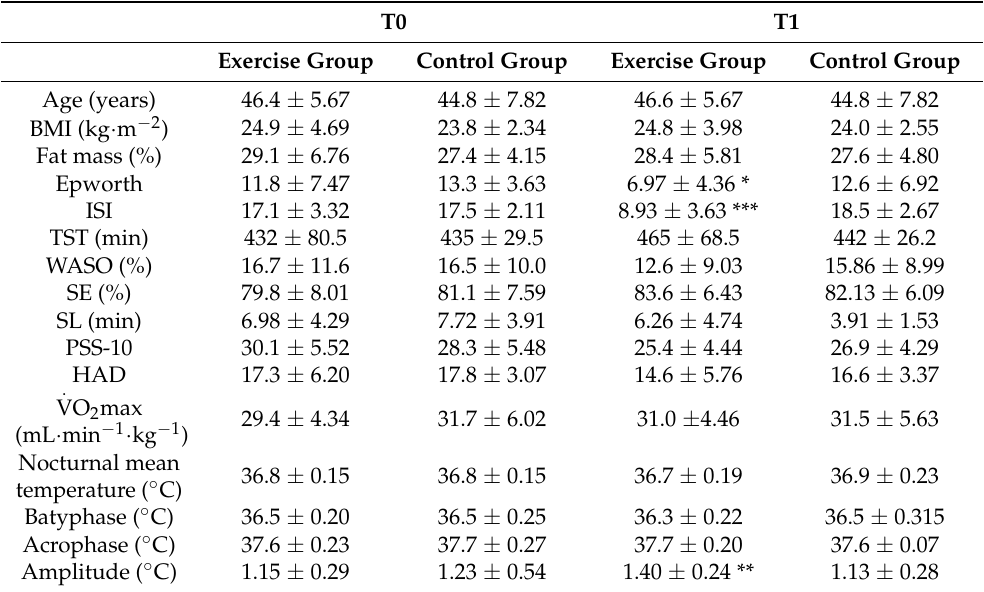
Table 1. Variables at T0 and T1 for each group. * p < 0.05 from the control group at T1. ** p < 0.01 from the control group at T1. *** p < 0.001 from the control group at T1. T0 T1 Exercise Group Control Group Exercise